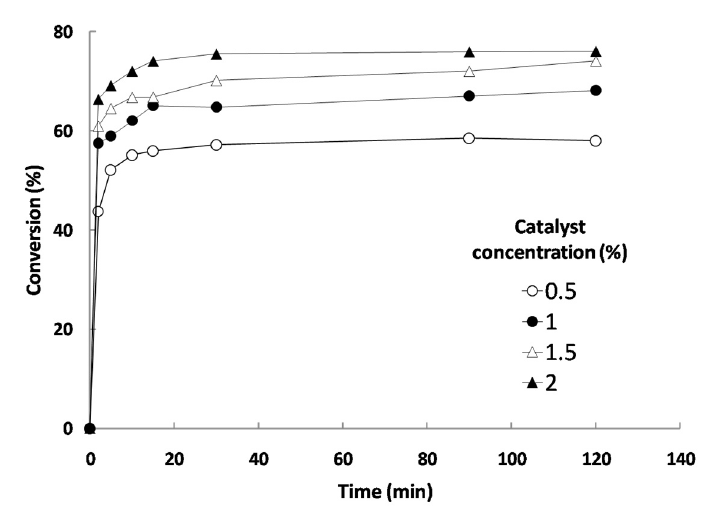
Figure 8. E ff ect of catalyst concentration on biolubricant production from FAMEs with 2,2-dimethyl-1,3-propanediol. Reaction conditions: Molar ratio, 1:1; 100 ◦ C; Ti(IV) isopropoxide Figure 8. Effect of catalyst concentration on biolubricant production from FAMEs with as a catalyst. 2,2-dimethyl-1,3-propanediol.Reaction conditions: Molar ratio, 1:1; 100 °C; Ti(IV) isopropoxide as a catalyst.